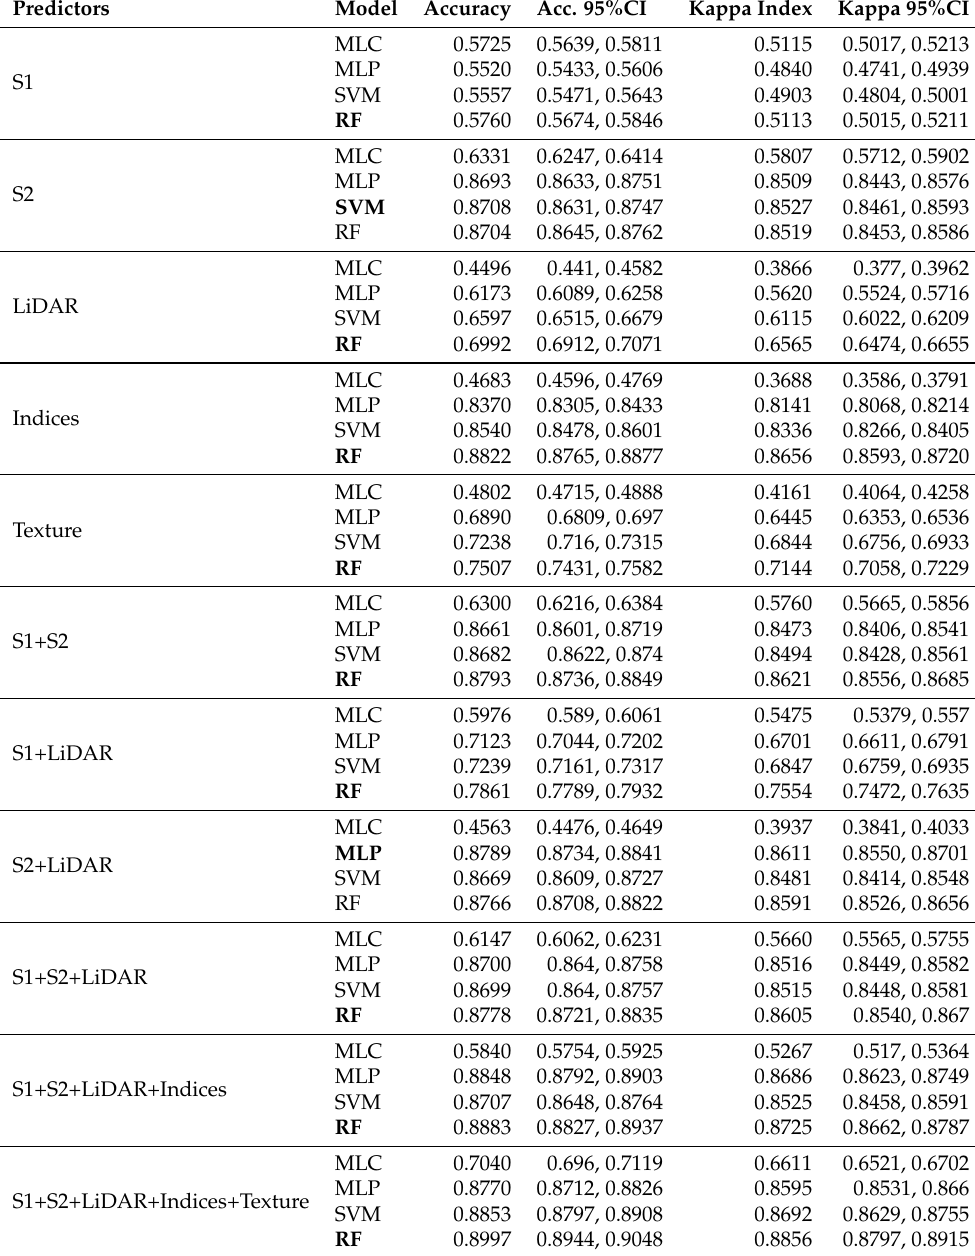
Table 5. Classification accuracy by dataset and classification method including overall accuracy and kappa index values with 95% confidence intervals. LOOCV by polygon ( n = 131). The most accurate algorithm is highlighted in bold for each dataset